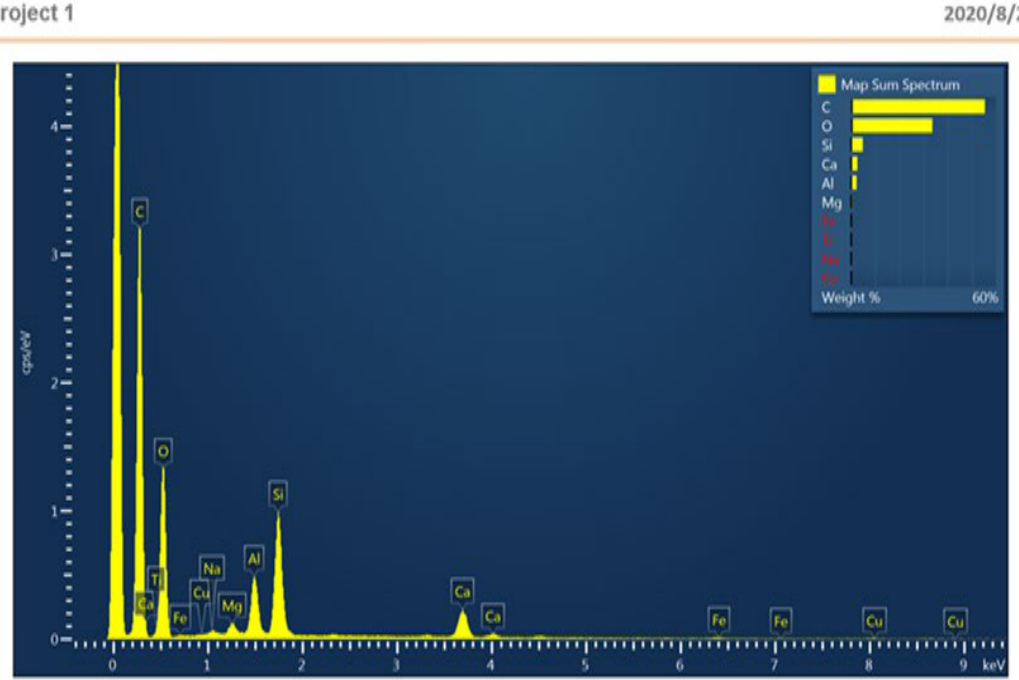
Figure 13. EDS analysis.